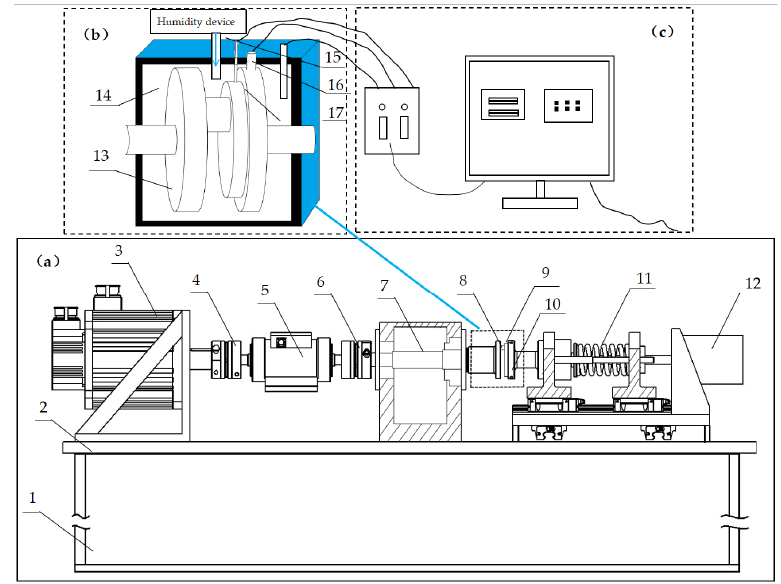
Figure 6. ( a ): Pin disc wear testing machine: (1)–cabinet; (2)–operating platform; (3)–drive motor; (4)–couplings; (5)–torque transducers; (6)–force sensor; (7)–drive shaft; (8)–pin specimens; (9)–disc specimens; (10)–disc fixture: (11)–telescopic shaft; (12)–motor; ( b ): brake friction pair:(13)–pin fixture; (14)–seal the control chamber; (15)–temperature sensor; (16)–high-temperature heating rod; (17)–humidity sensor; ( c ): PLC computer control system.